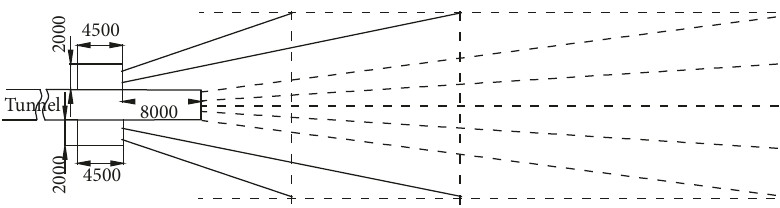
Figure 17: Schematic diagram of tapered curtain drilling arrangement design.